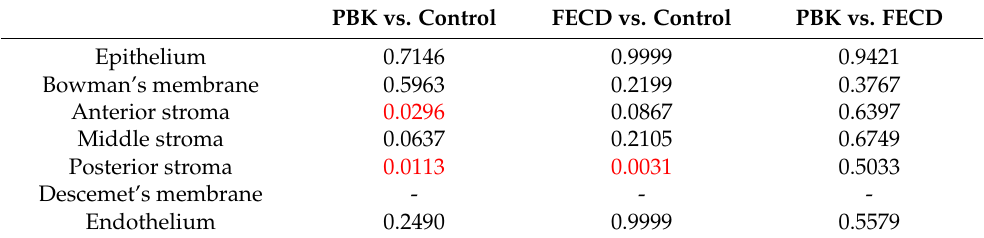
Table 8. Comparison of aggrecan expression in the different corneal layers in normal and diseased groups. PBK vs. Control FECD vs. Control PBK vs. FECD